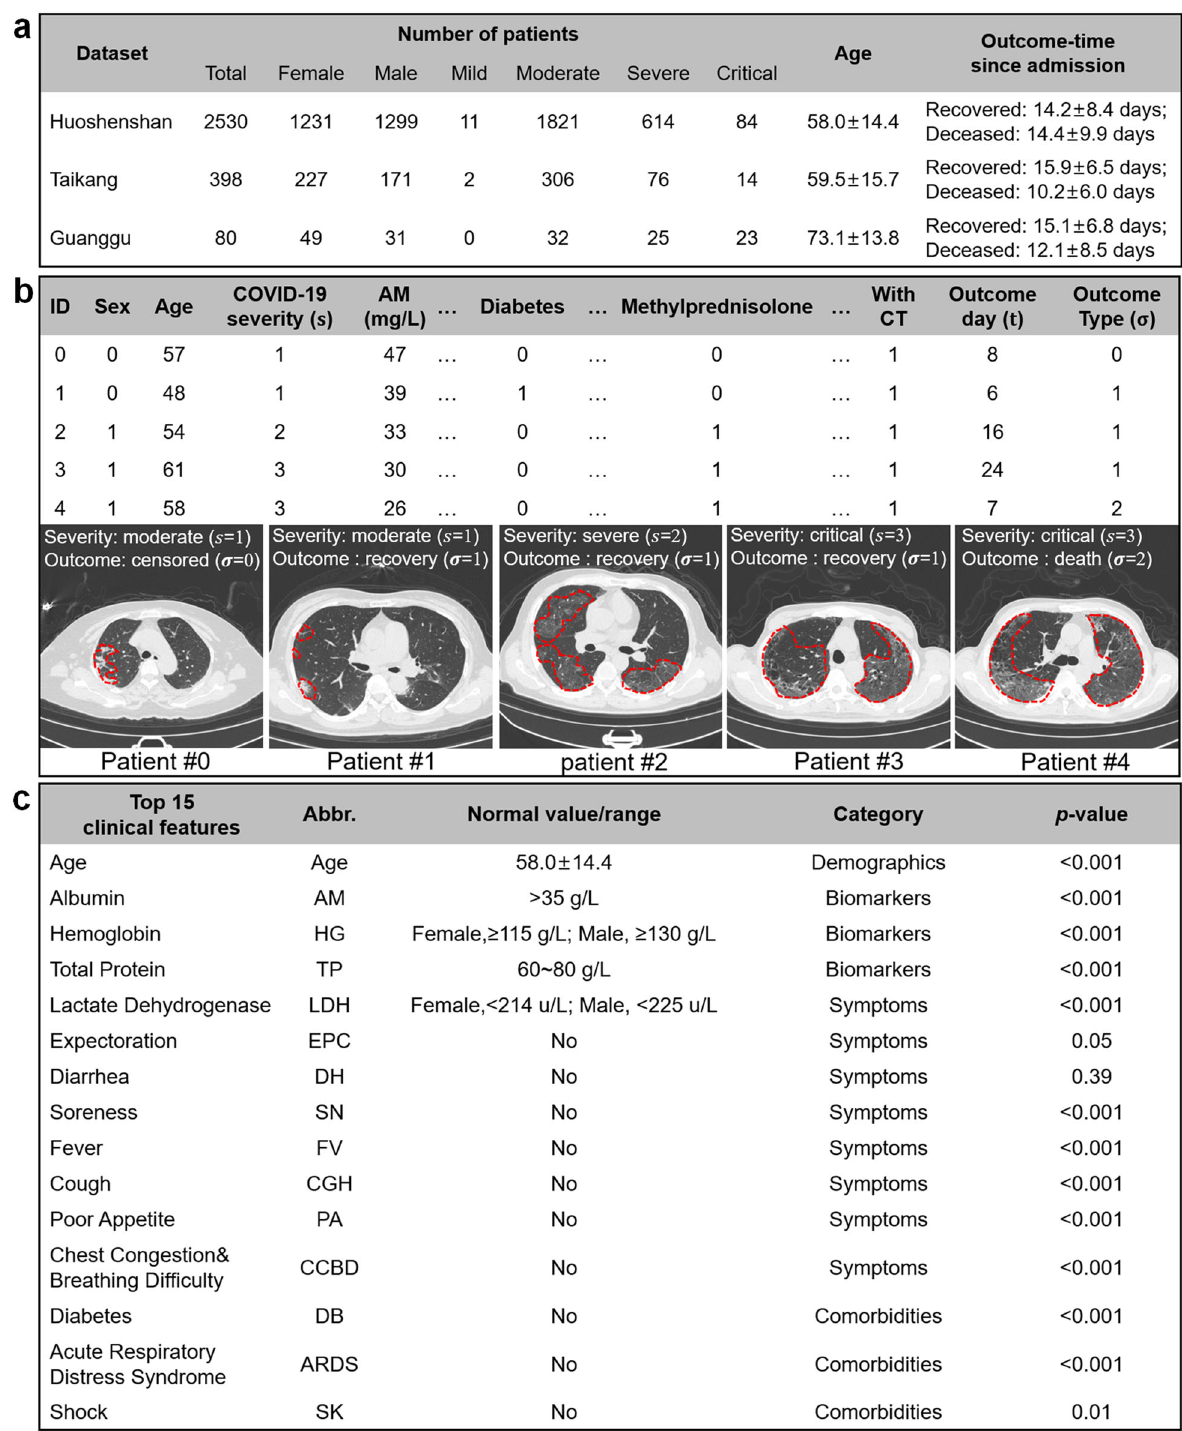
Fig. 2 Data set information. a Patient information of the three cohorts. b Five samples of the patients ’ tuple information. c The top 15 clinical features identi fi ed via the proposed FSR mechanism that are signi fi cant to the recovery-time prediction of COVID-19 patients. p values calculated via a Pearson correlation analysis demonstrate that these features are indeed highly related to the recovery